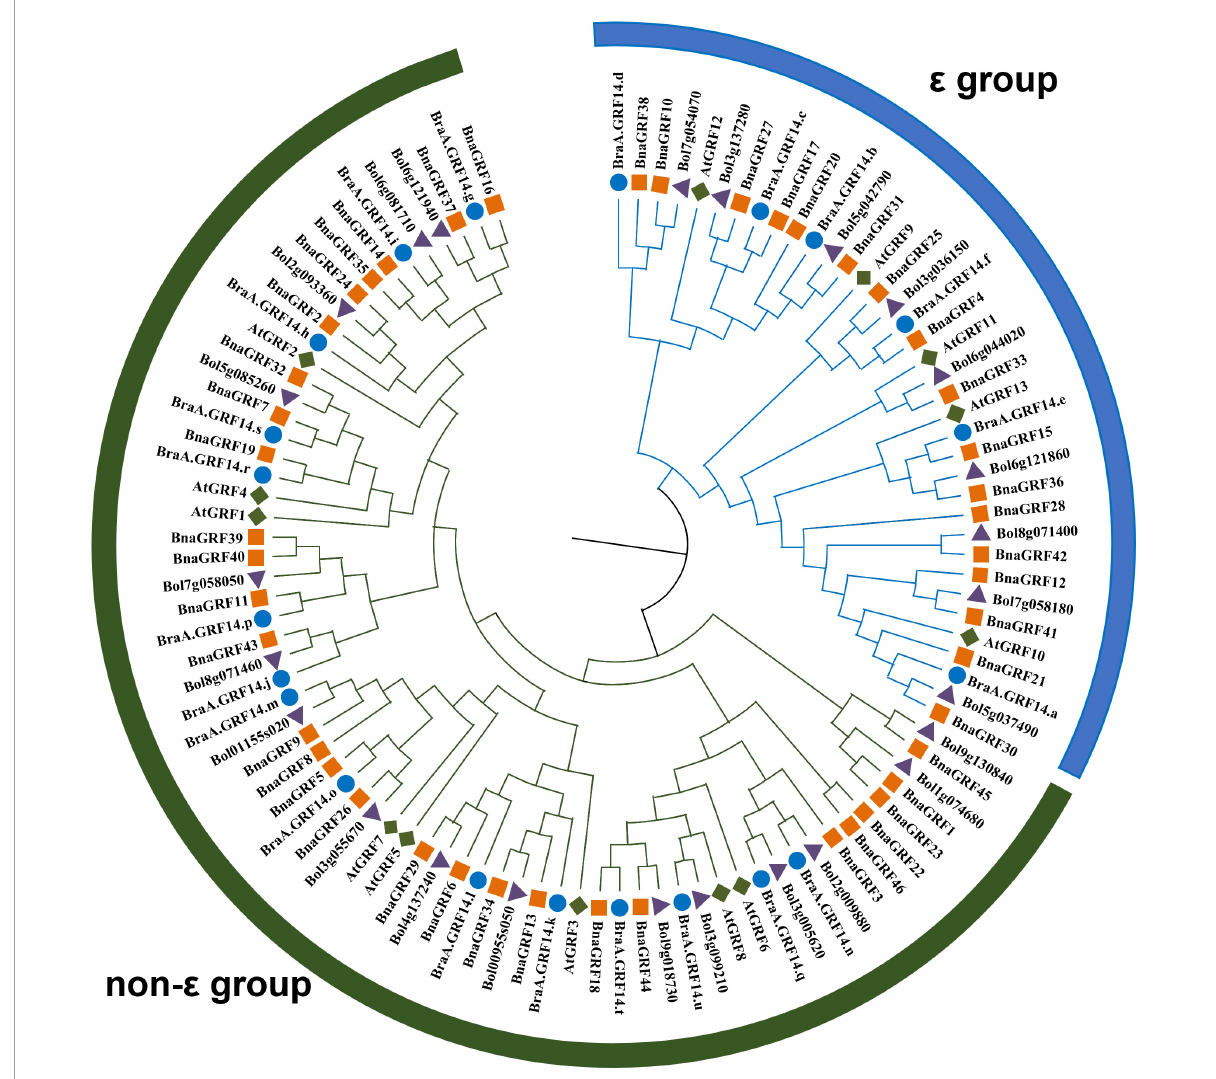
FIGURE1 Phylogenetic analysis of the 14-3-3 protein family in Brassica species ( B . rapa , B . oleracea , and B . napus ) and Arabidopsis thaliana . A total of 46 14-3-3s were divided into two subgroups ( ε and non- ε group), according to the evolutionary distance. Blue circles represent the 21 BraGRFs in B . rapa ; purple triangles represent the 25 BolGRFs in B . oleracea ; orange squares represent the 46 BnaGRFs in B . napus ; and green diamonds represent the 13 AtGRFs in